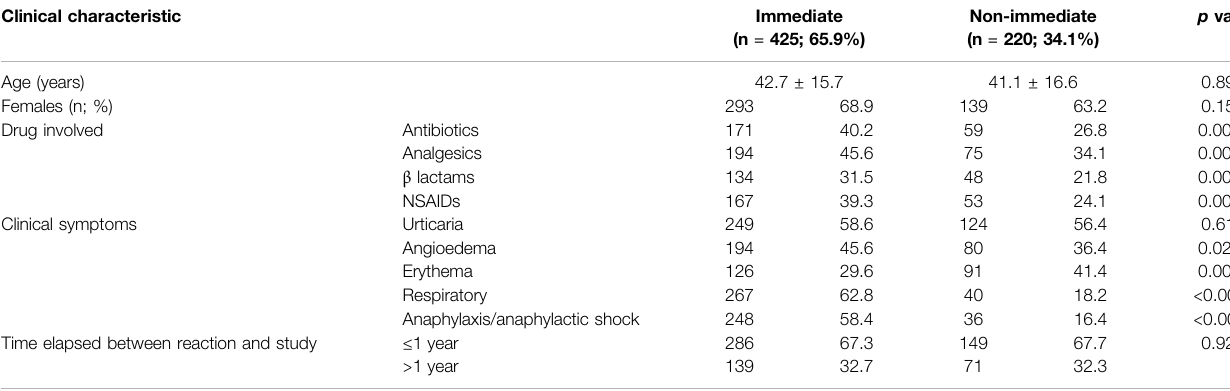
TABLE 4 | Clinical characteristics among patients with con fi rmed drug allergy in regard to immediate and nonimmediate drug allergy reactions. Clinical characteristic